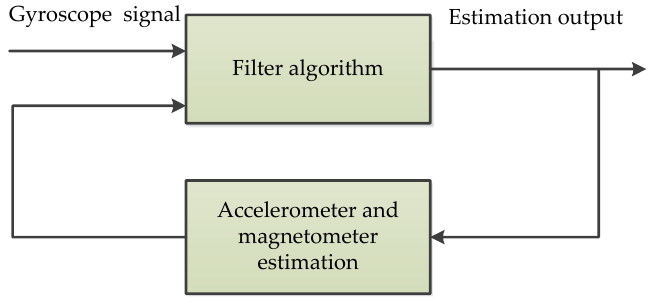
Figure 11. The simplified fusion scheme of heterogeneous fusion.